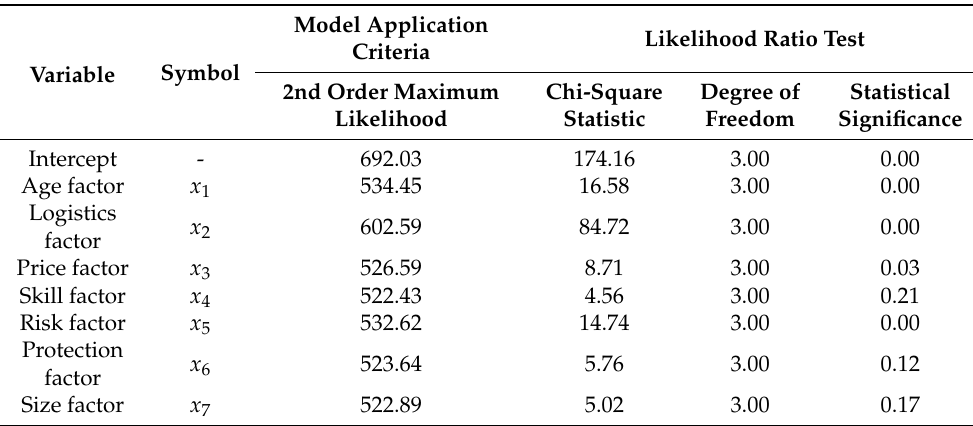
Table 5. Maximum likelihood ratio test